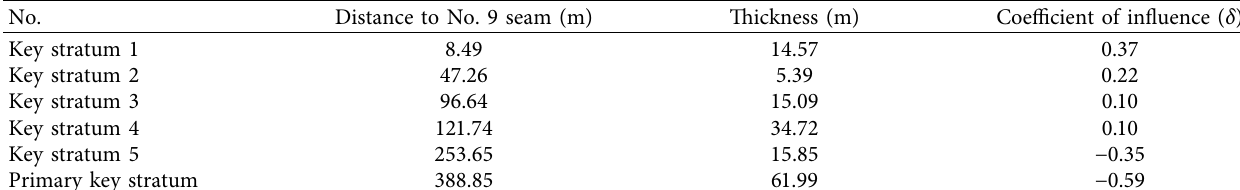
Table 1: Coefficients of influence of the key strata on advanced abutment pressure of panel